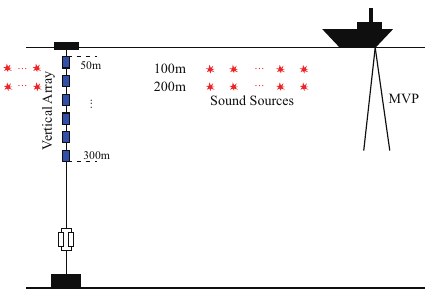
Figure 13. Experimental installation in the western North